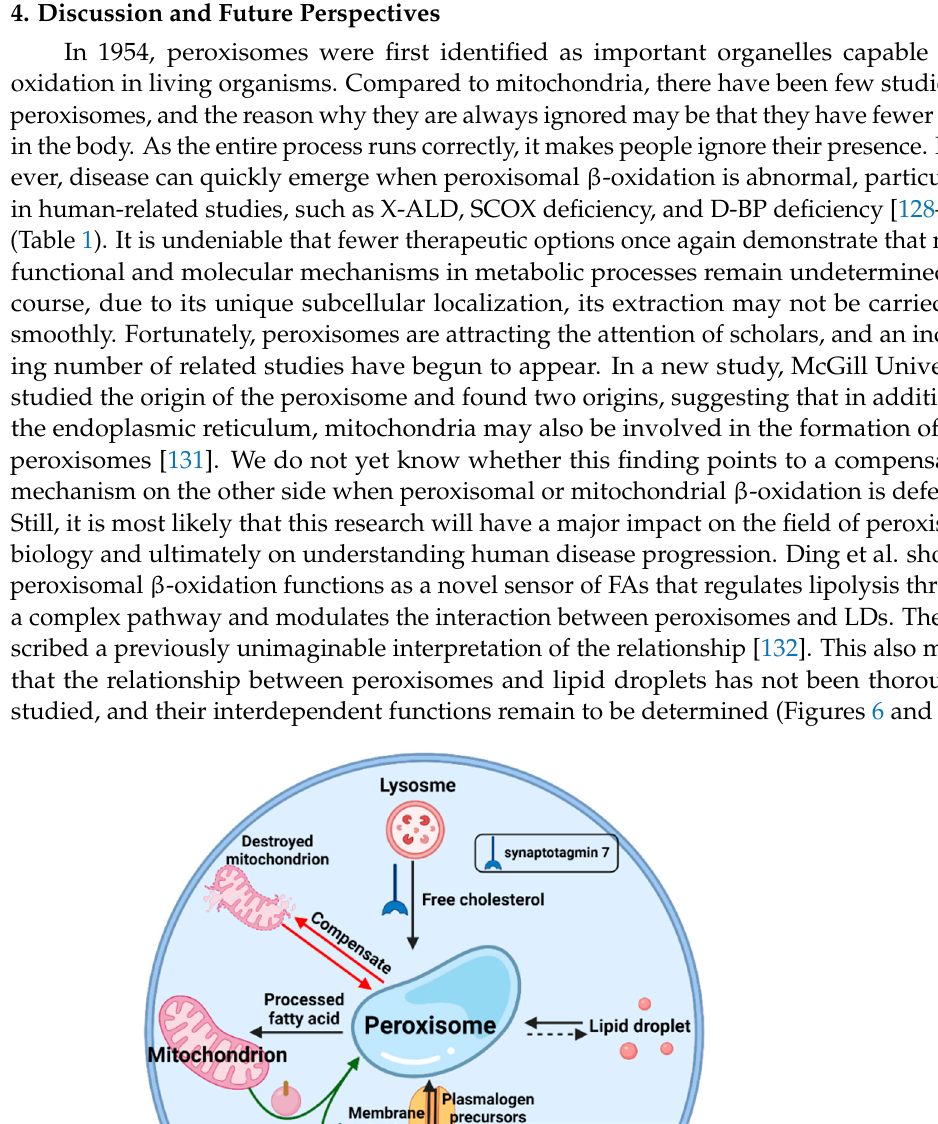
Figure 7. The transfer of fatty acids from peroxisomes to mitochondria.